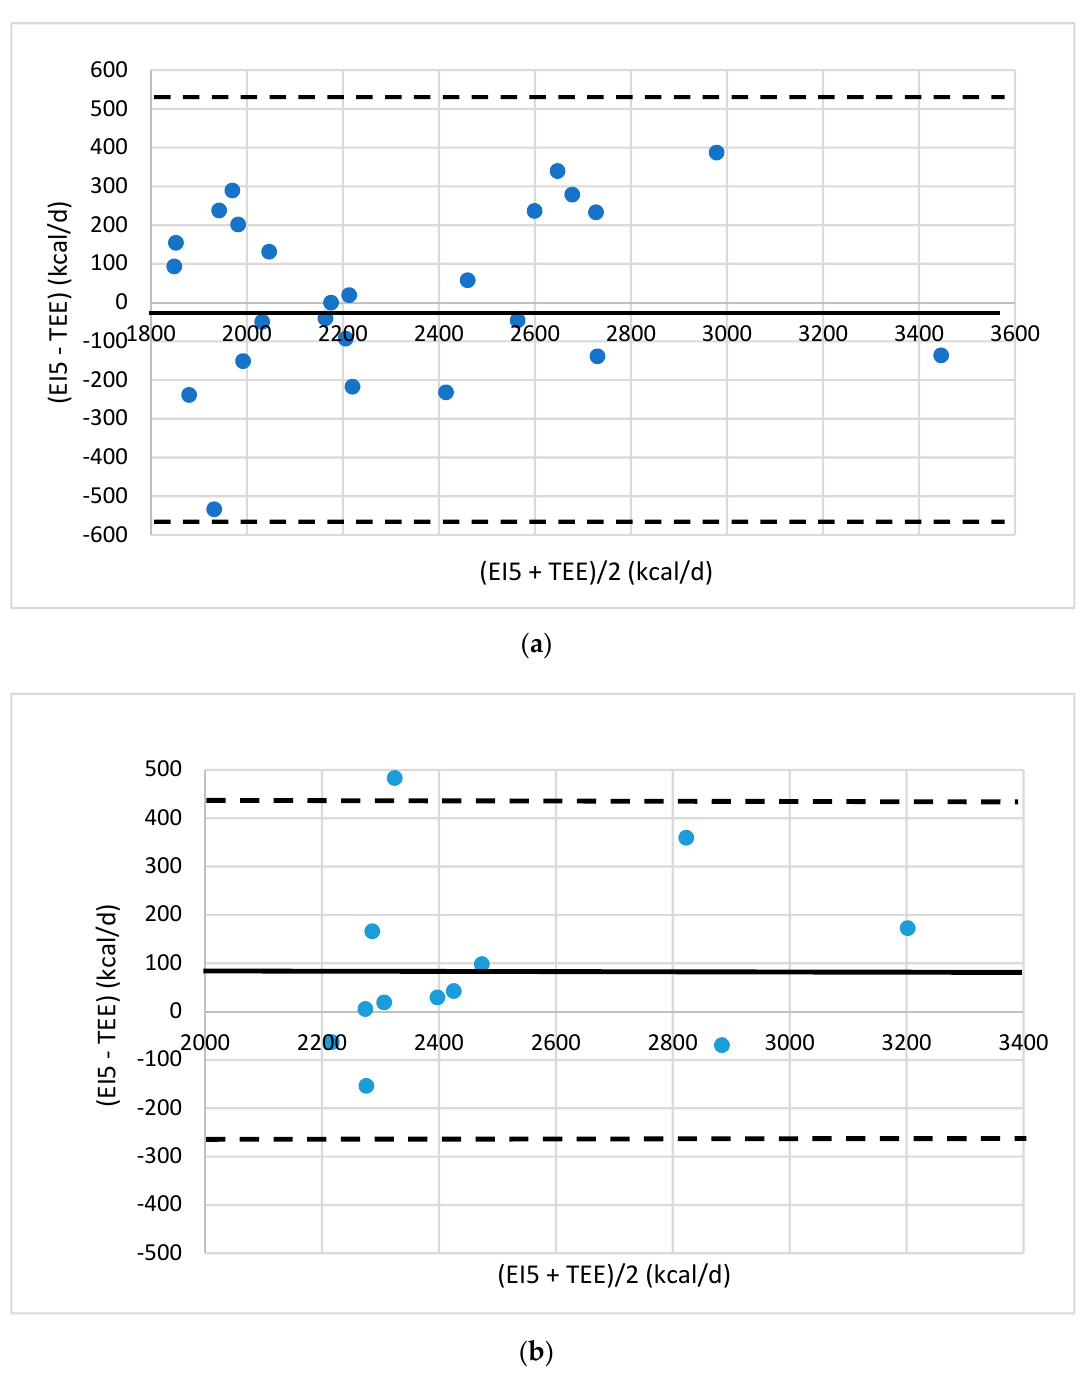
Figure 5. Bland – Altman plots of the agreement level between total energy expenditure (TEE) meas- Figure 5. Bland–Altman plots of the agreement level between total energy expenditure (TEE) measured by eMouve, and ured by eMouve, and energy intake (EI5) estimated by NutriQuantic in normal-weight women ( a ) energy intake (EI5) estimated by NutriQuantic in normal-weight women ( a ) in the training group and ( b ) in the test group. in the training group and ( b ) in the test group. Bias is represented as mean difference (two standard Bias is represented as mean difference (two standard deviations).